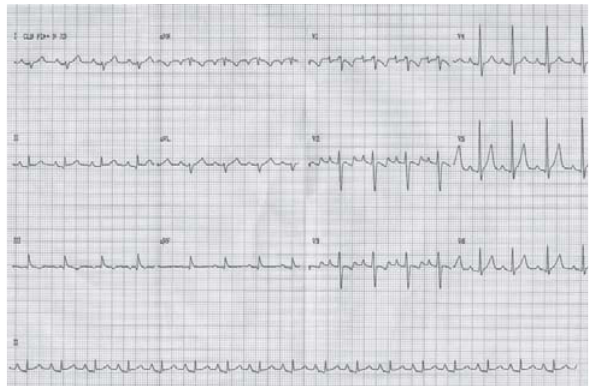
Fig. 1 – Eletrocardiograma com intervalo PR prolongado e sobrecarga de átrio direito frequentemente observado na doença de